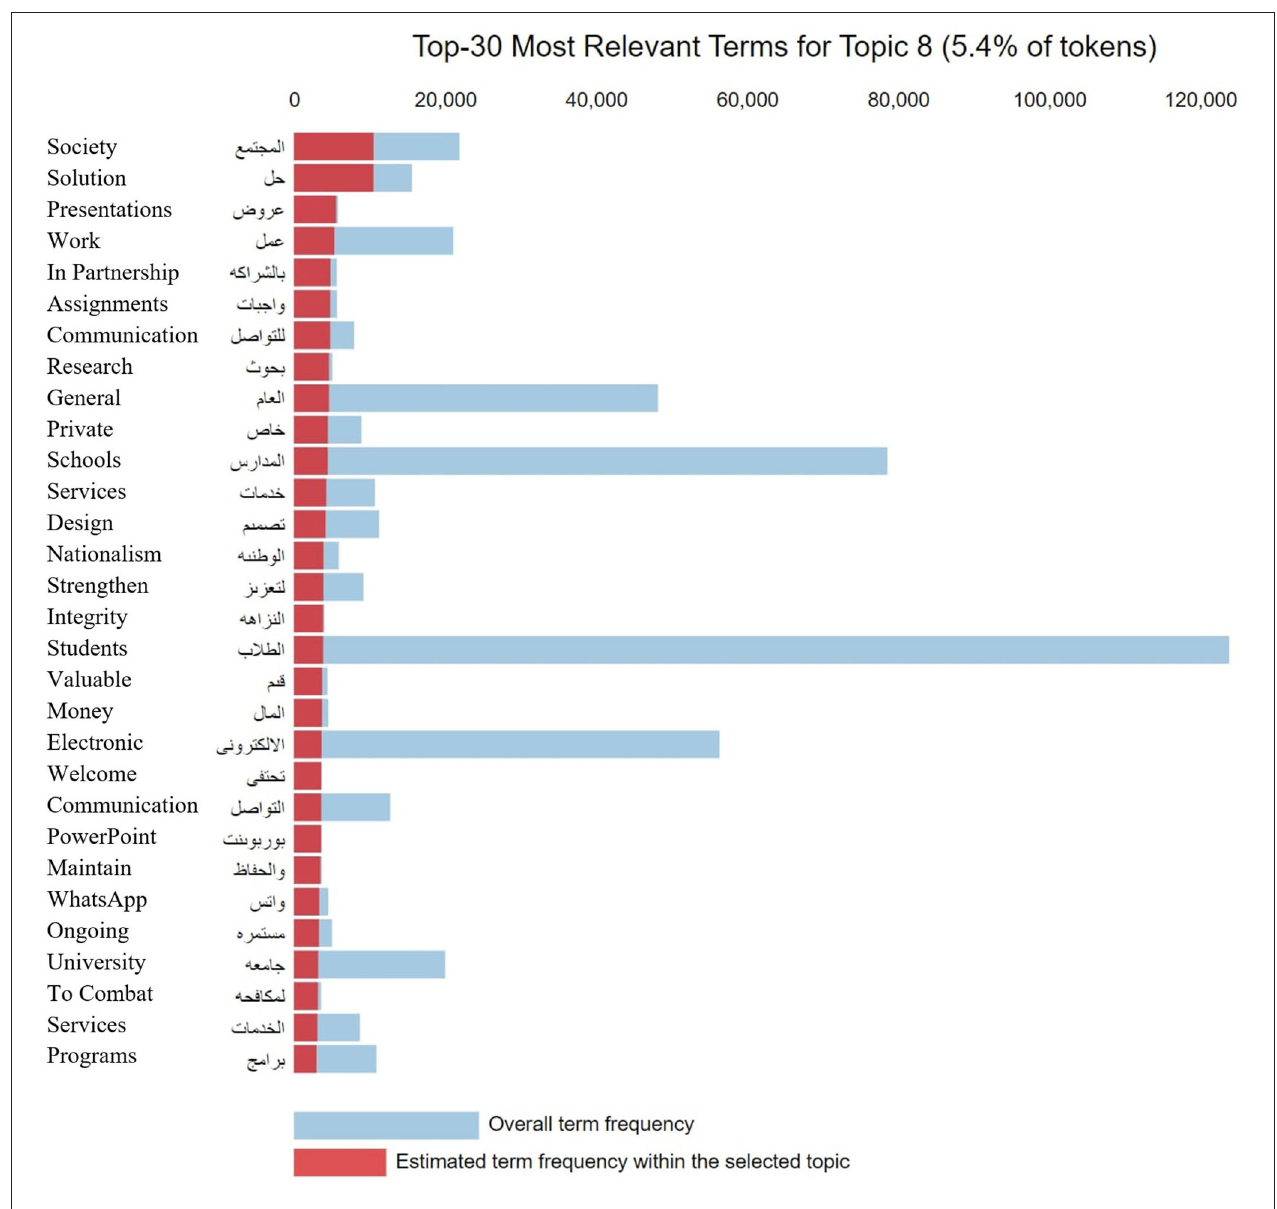
FIGURE 8 | The top 30 most relevant keywords/key terms by frequency (Topic